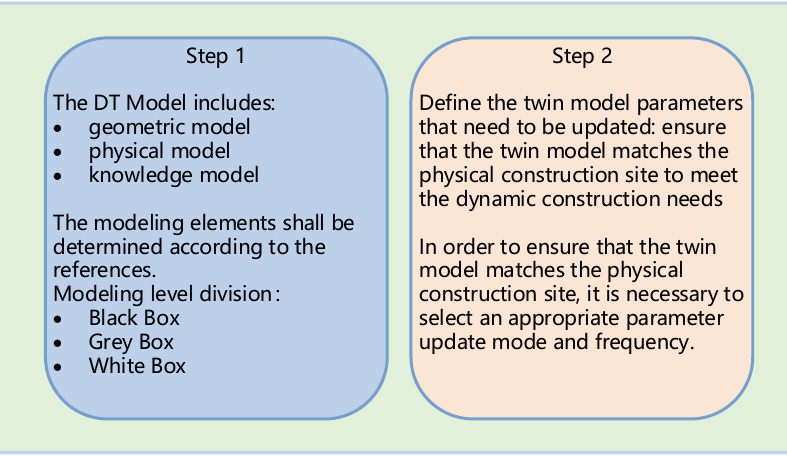
Figure 2. Two phases of creating the digital twin